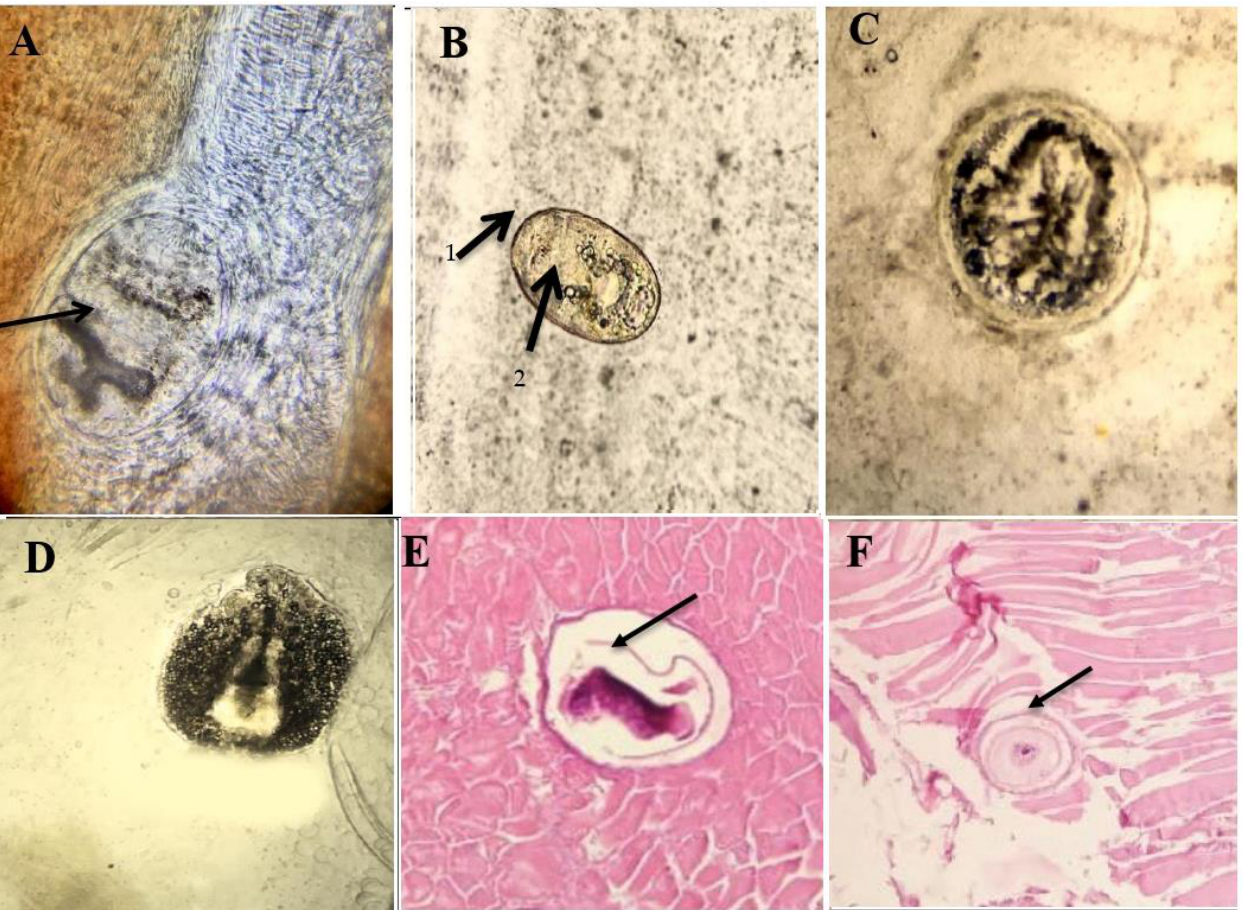
Figure 4. Microscopic EMC of Nile tilapia. ( A – D ) Different types of encysted metacercariae in gill filaments of Nile tilapia ×100: ( A ) Centrocestus formosanus (arrow shows x-shaped execratory bladder); ( B ) Echinostomatide EMC (arrows show (1) spines and (2) granular execratory bladder); ( C ) Prohemistomum EMC in muscle X100; ( D ) Diplostomatids EMC in muscle ×100; ( E , F ) encysted metacercariae in fish muscle (arrows)b(H&E stain) ×100.